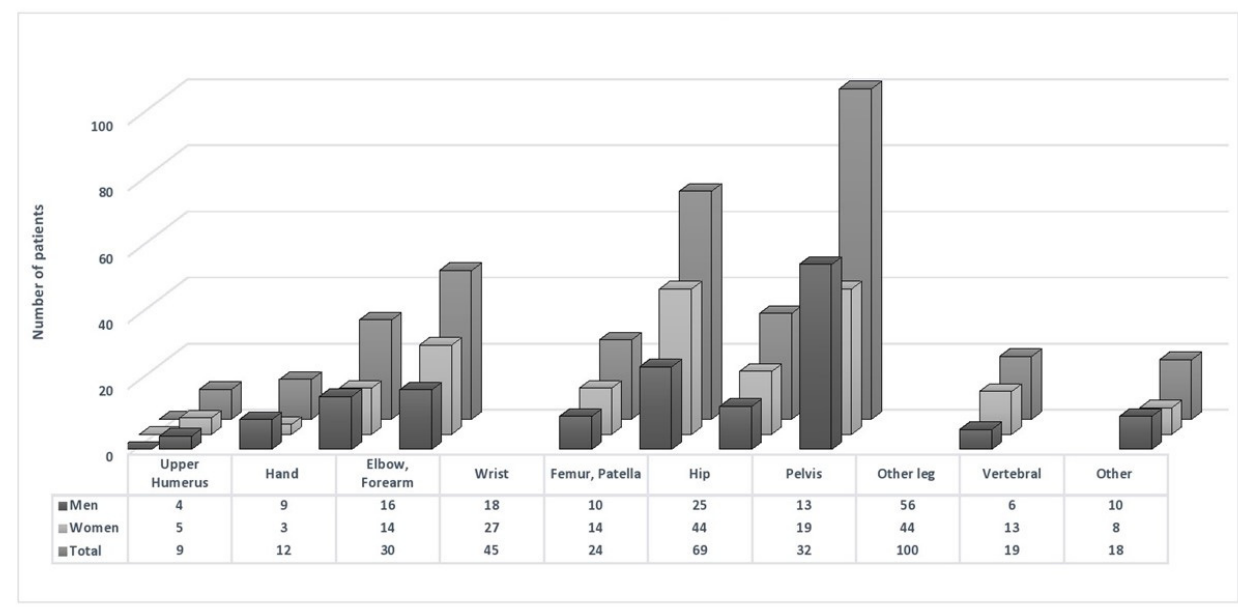
Figure 1. Number of patients across different types of fracture. Table 3. Multivariable hazard ratios (HR) and 95% confidence intervals (CI) of incidence of any fracture for wrist circumference as a continuous variable: Tehran Lipid and Glucose Study, 1999–2016.